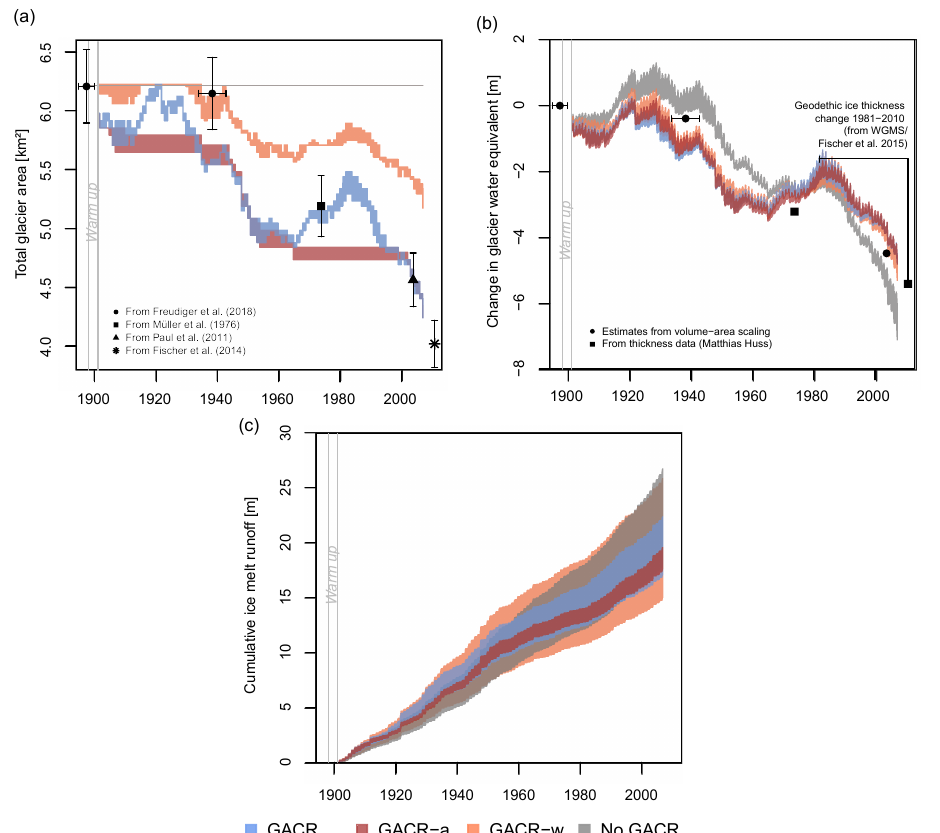
Figure 4. Comparison of the simulations by the different versions of the glacier routine: (a) total glacier area, (b) change in glacier storage, and (c) cumulative glacier ice melt runoff (this is the runoff originating from ice melt, which is tracked through the model; snowmelt on the glacier is not included). The range of simulation results represents the results from 10 model (equally suitable) parameterizations for each of the different versions of the Glacier Area Change Routine (GACR) and for the version without Glacier Area Change Routine (see Sect. 2.2 for the definition of model-variant abbreviations). All simulations started with the same glacier volume and area and differences in 1901 were caused by differences in the simulations during the 3-year warm-up period. The uncertainties for the observed glacier volumes and areas were best estimates based on the available information in the respective publications. The geodetic ice thickness change from 1981 to 2010 (Fischer et al., 2015) was not used in model calibration but added here for